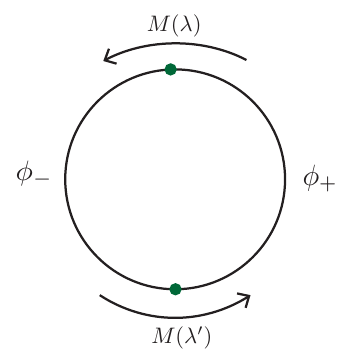
Figure 12. Illustration of two CFT domain walls at the opposite sides of a periodic